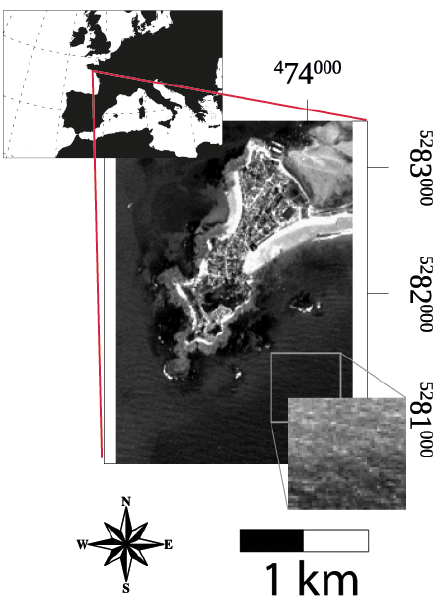
Figure 1. Study area and an example Sentinel 2 sub-image (band 4). The square represents a histogram-stretched cut of the image, highlighting the waves therein. Coordinates are expressed in UTM N30 .